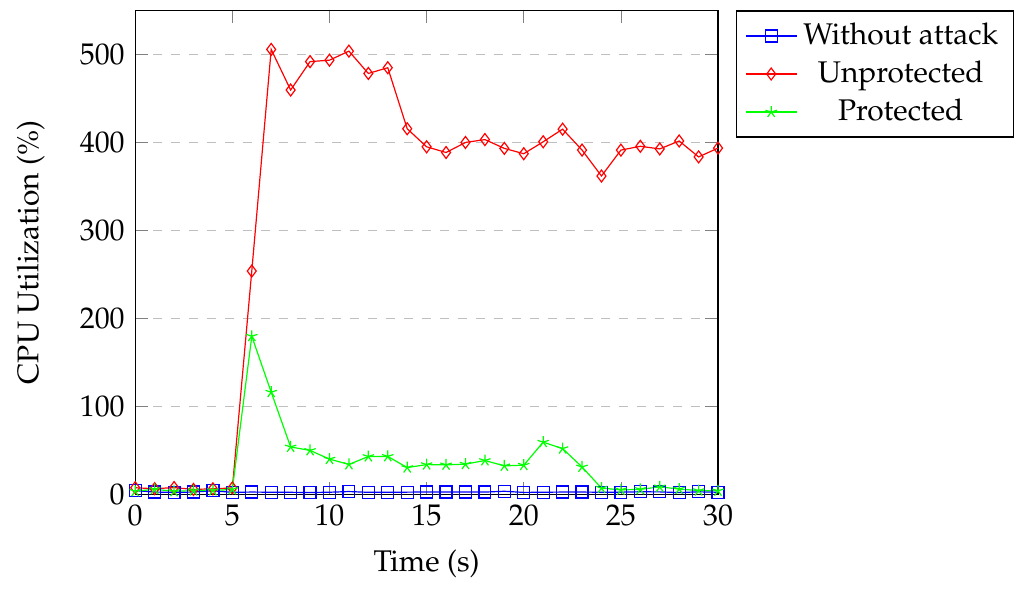
Figure 21. Controller CPU under SYN flood.